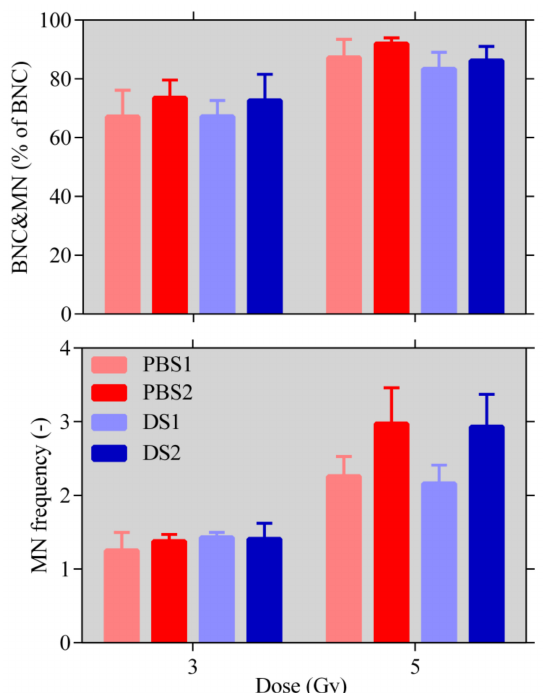
Figure 4. The percentage of binuclear cells (BNC) containing micronuclei (MN) from the total number of BNC and the micronuclei frequencies for the two modes and the two positions in the proton beam for doses of 3 and 5 Gy. No statistically significant di ff erences have been found using the t -test.